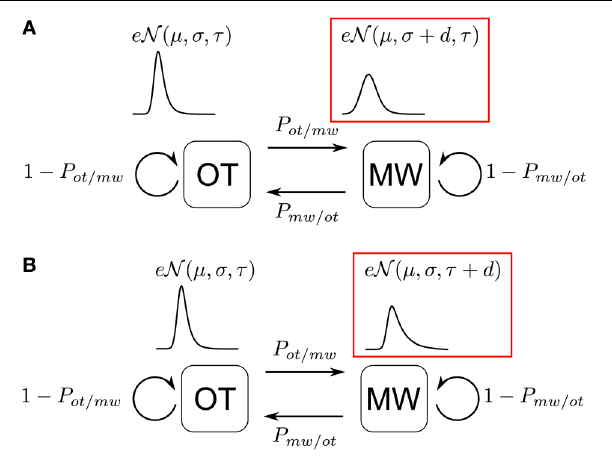
FIGURE 4 | Six-Parameters Models accounting for increased variability during mind wandering. P ot / mw : transition probability to start mind wandering when on-task, P mw / ot : transition probability to come back on task when mind wandering, μ : mean of the distribution, σ : variance of the distribution, τ : skewness of the distribution. The critical parameter is d , “difference parameter,” applied either to σ (“variance model”) if variance increases during mind wandering, or to τ (“exponential model”) if skewness increases during mind wandering. (A) Variance Model (B) Exponential